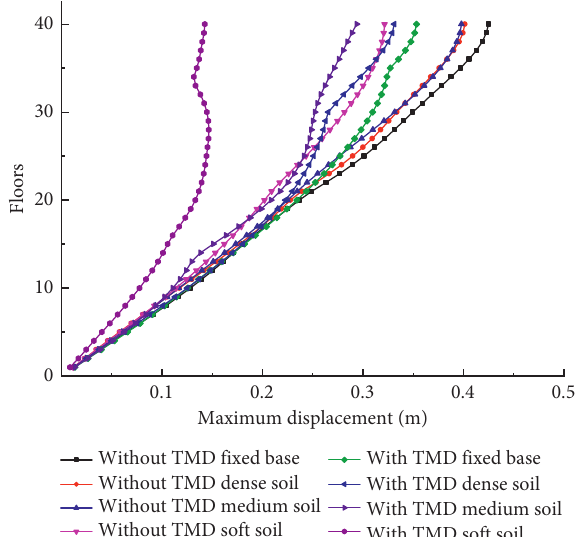
Figure 9: EL Centro earthquake maximum floor displacement comparison chart.